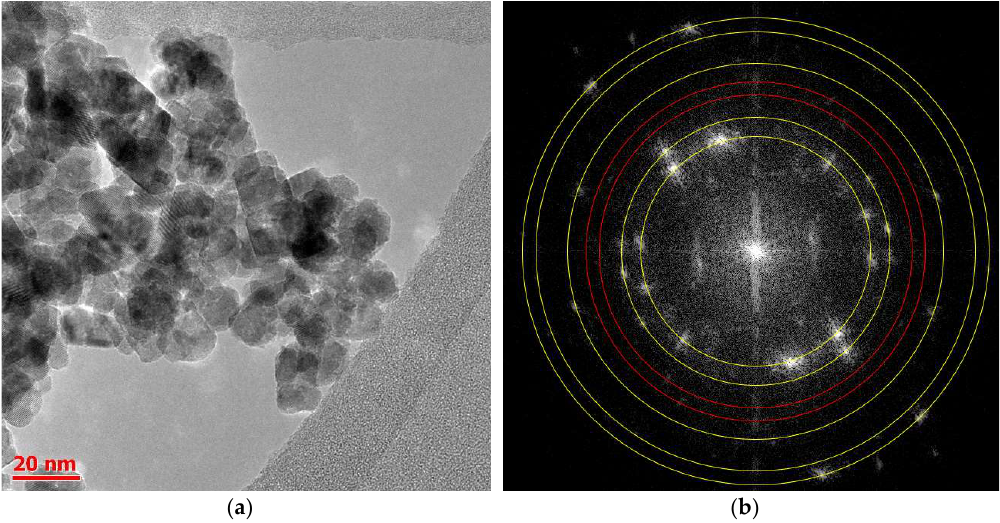
Figure 2. ( a ) HRTEM micro-image of Pd/CeO 2 ; ( b ) FT image with circles related to the diffraction from CeO 2 (yellow), Pd and PdO (red). The original direct HRTEM image of ( b ) is shown in Figure S4.